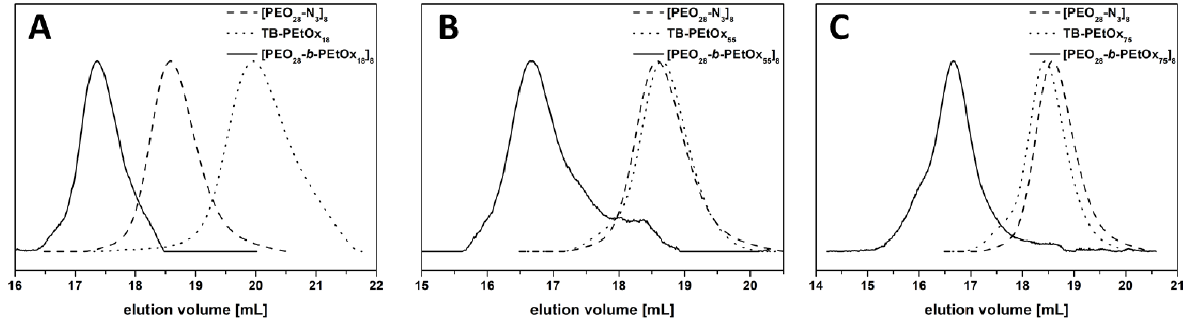
Figure 2. SEC traces using DMAC/LiCl as the eluent for TB-PEtOx [PEO -N ] (scattered line) and the obtained purified star-shaped [PEO 28 3 8 - b -PEtOx (solid line): ( A ) [PEO 28